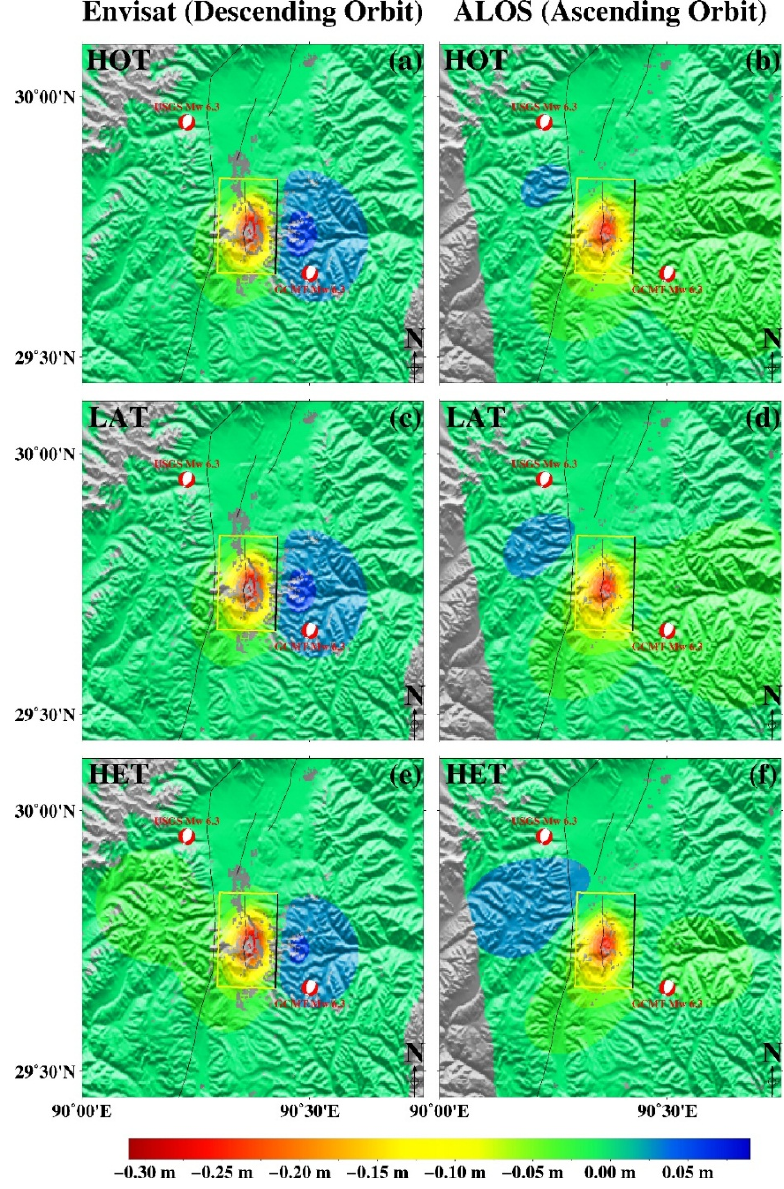
Figure 12. Predicted coseismic deformation for the descending and ascending datasets in LOS. ( a ), ( c ), and ( e ) Envisat ASAR Track 176 estimated by the HOT, LAT, and HET models , respectively; ( b ), ( d ), and ( f ) ALOS PALSAR Track 500 estimated by the HOT model, LAT model, and HET model, respectively. Yellow box denotes the fault surface projection on the ground with the black line as its top. Thin black lines denote the Quaternary active faults [36]. Red beach balls represent the earthquake source mechanisms (from USGS and GCMT).